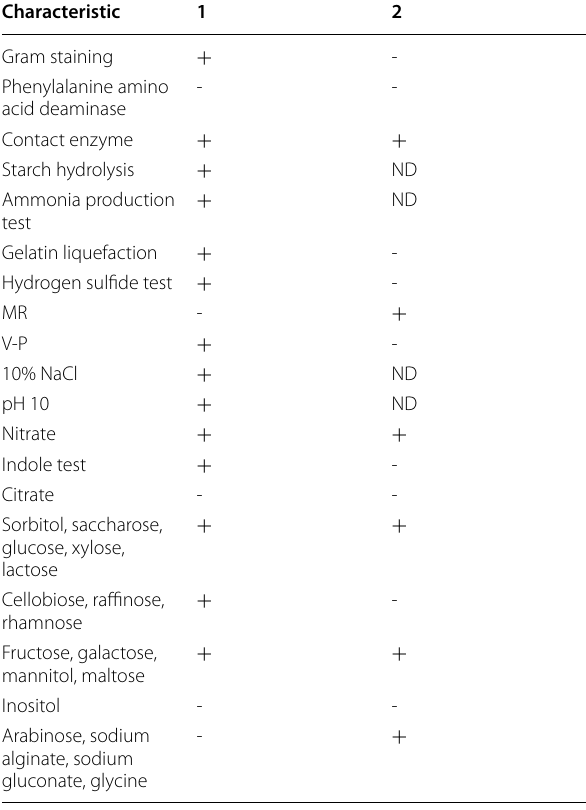
Strains: 1, K-9; 2, E. coli . Data are from this study, unless otherwise